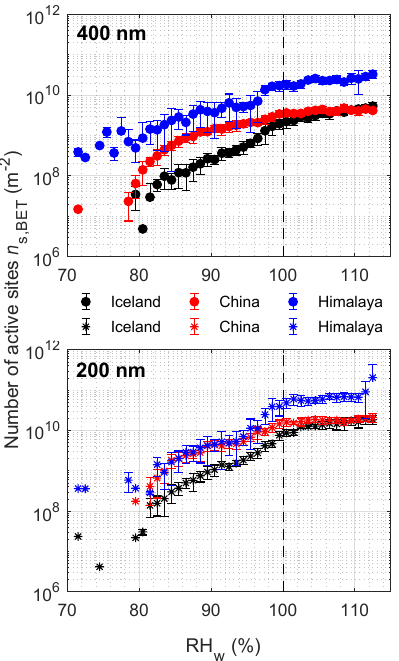
Figure 6. Average n s , BET values as a function of RH w for three heated dusts of 400 and 200nm in diameter at 238K. The values are averaged into 1% RH w bins, and the error bars represent 1 standard deviation. The vertical dashed line is the water saturation (RH w = 100%)